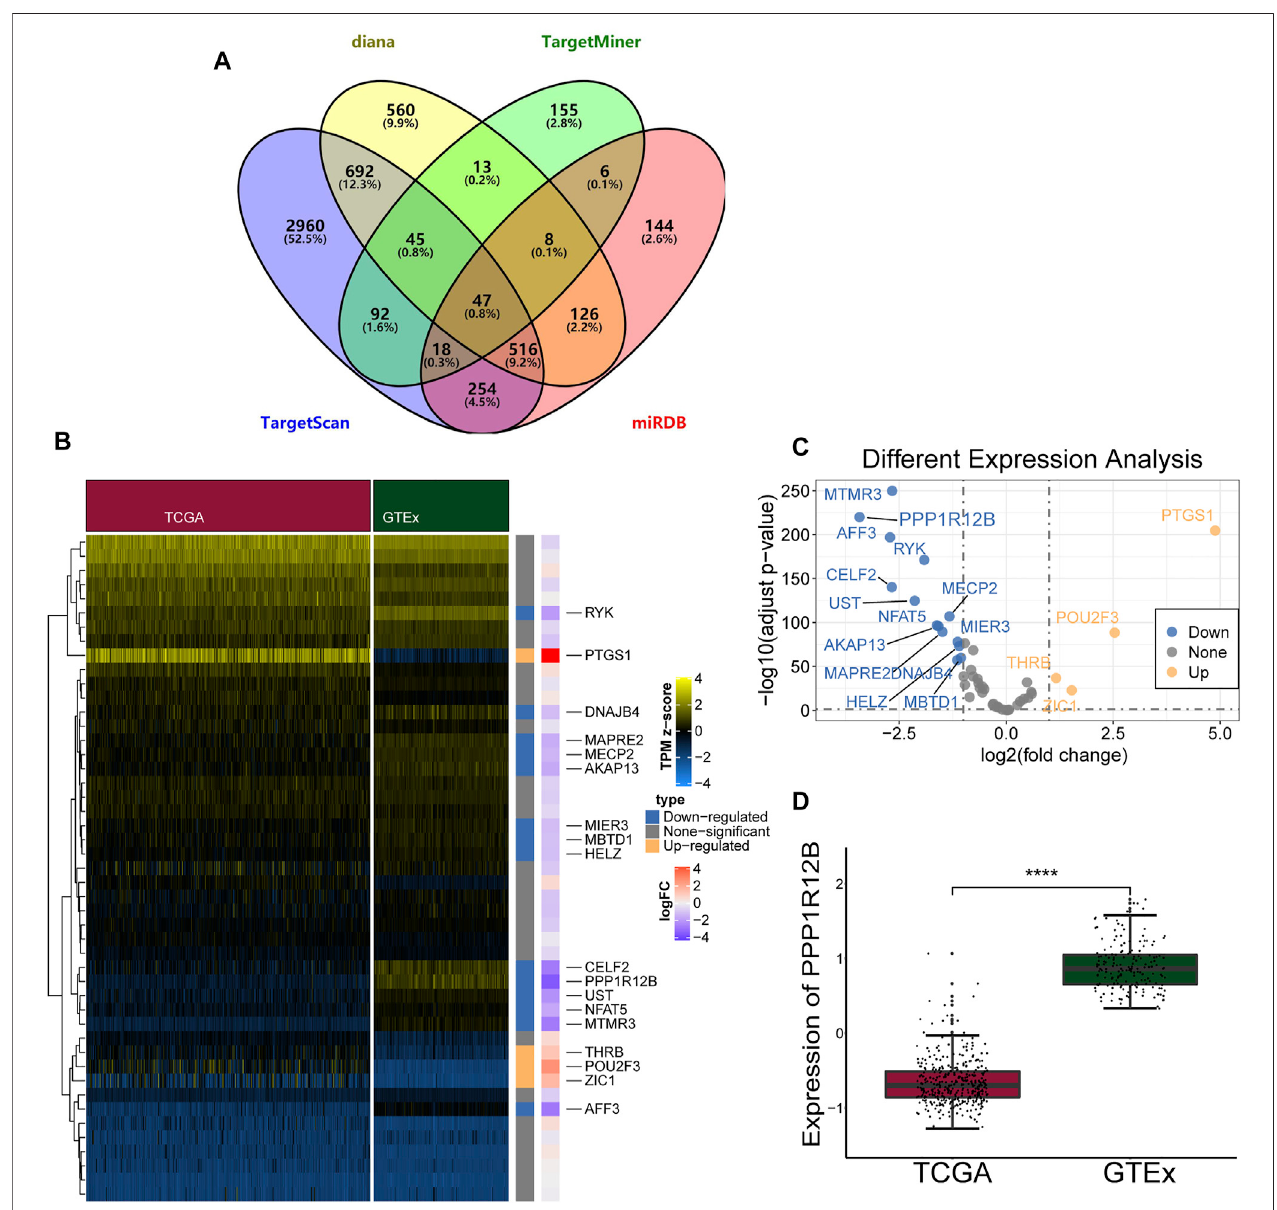
FIGURE 8 | The predicted target mRNAs of miR-1299. (A) Candidate mRNAs predicted by four databases to target miR-1299. (B,C) Heatmap (B) and volcano plots (C) showed different expressed genes that bind to miR-1299 in TCGA and GTEx. (D) The different expression of PPP1R12B in TCGA and GTEx. These results were presented as the mean ± SDs. **** p <